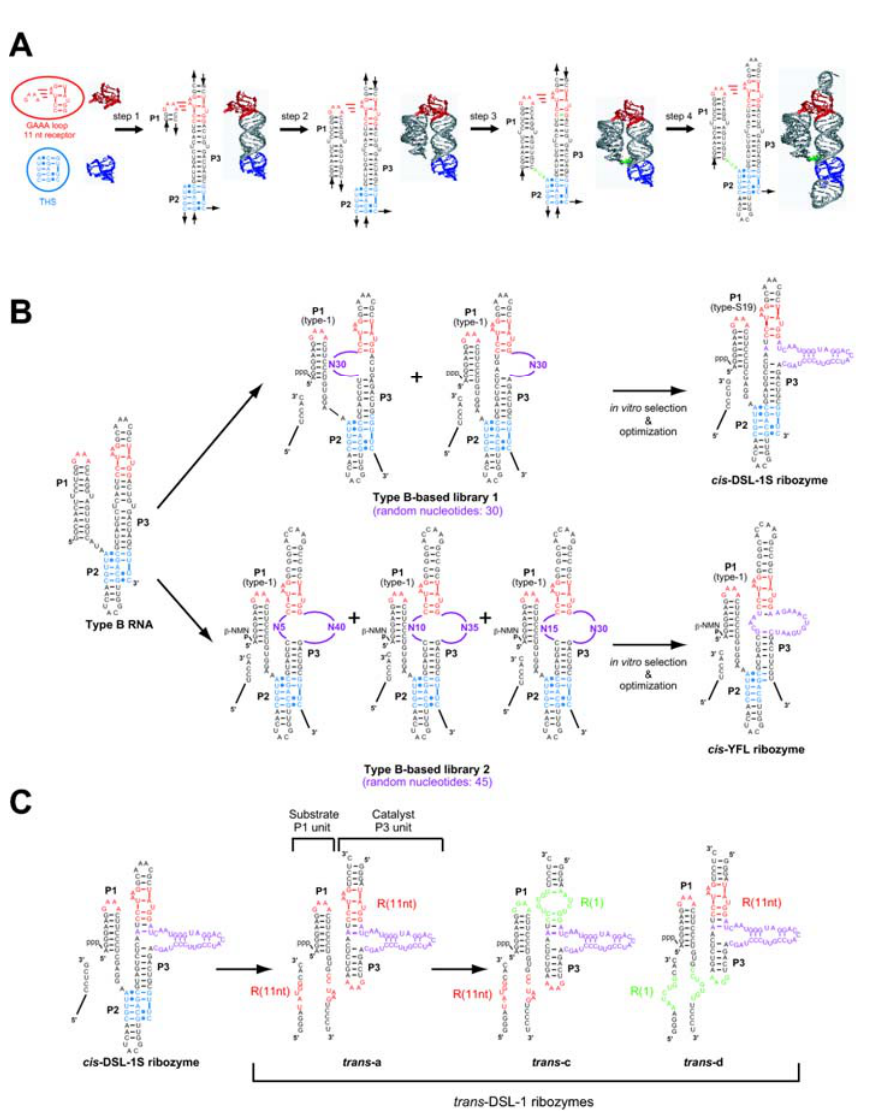
Figure 5. Design, generation, and modification of modular ligase ribozymes. (A) Outline of the rational design of the self-folding type-B RNA. (B) Construction scheme of the two classes of modular ribozymes with RNA-RNA ligation activity. The cis -DSL-1S ribozyme was evolved by selection with inorganic pyrophosphate as a leaving group for RNA ligation. The cis -YFL ribozyme was evolved by selection with  -nicotinamide monophosphate (  -NMN) as a leaving group for RNA ligation. (C) Modular engineering of the class-DSL ribozyme for rational construction and optimization of trans -acting derivatives consisting of the substrate P1 unit and the catalytic P3